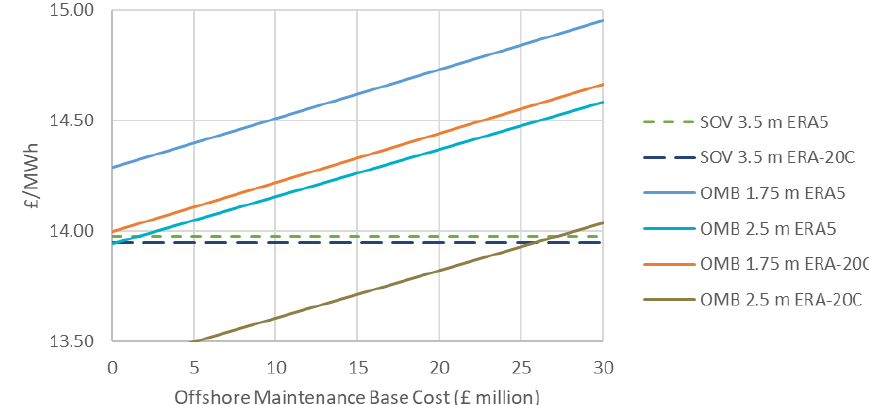
Figure 7. Six scenarios compared with varying the costs associated with the OMB.